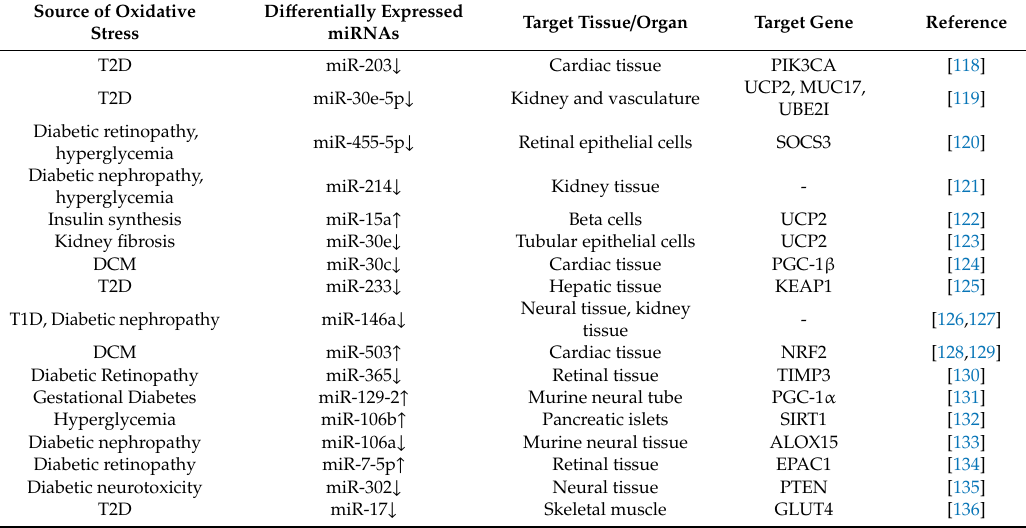
Table 1. Selected PubMed articles describing miRNAs in diabetic oxidative